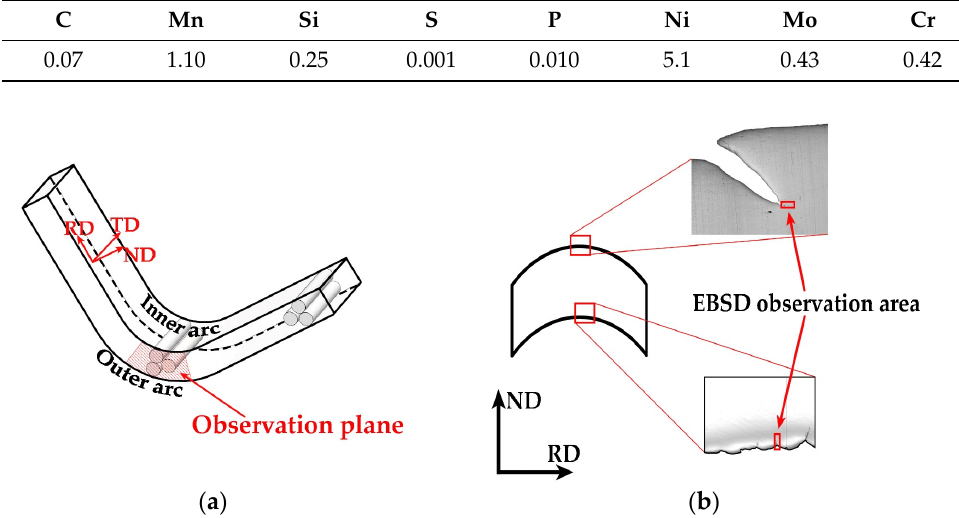
Figure 1. The sketch maps of the specimens: ( a ) OM observation plane and locations of tensile samples, and ( b ) EBSD observation zone.